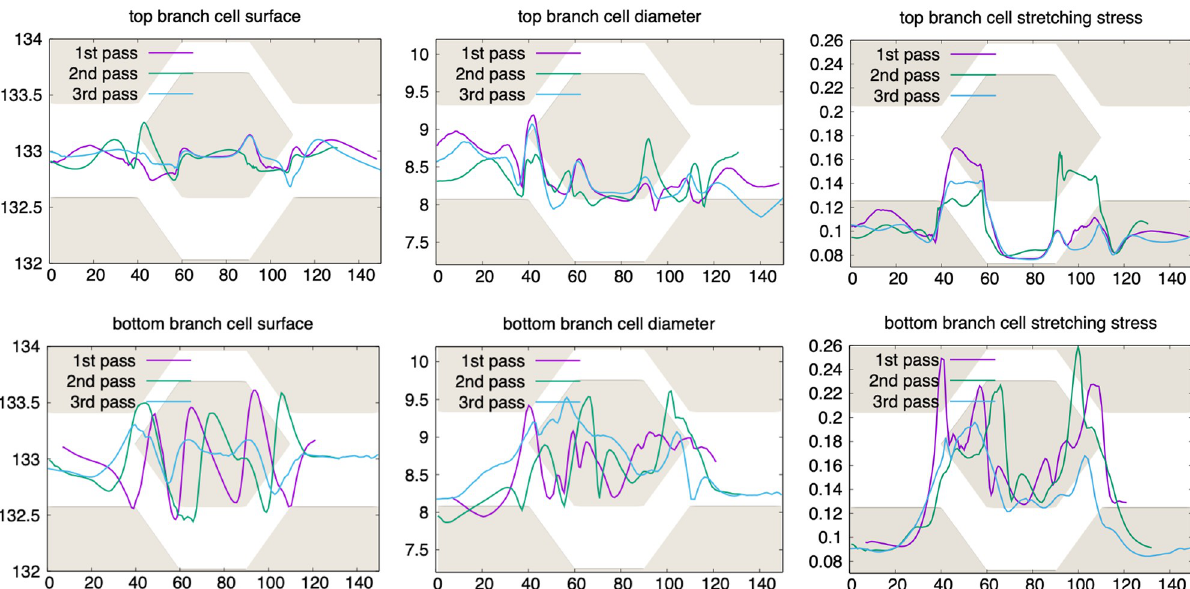
Fig 4. Quantitative characteristics of cells in bifurcation. The horizontal axis shows the x -coordinate of the cell’s center of mass. The cell’s surface, diameter and rotation angle during the first pass (purple line), the second pass (green line) and the third pass (blue line) through the bifurcation are shown on the y -axis. First row: data for the red blood cell passing through the narrower top branch, second row: data for the red blood cell passing through the wider bottom branch. The bifurcation depicted as a background image helps to link the data to the spatial location of the cell inside the